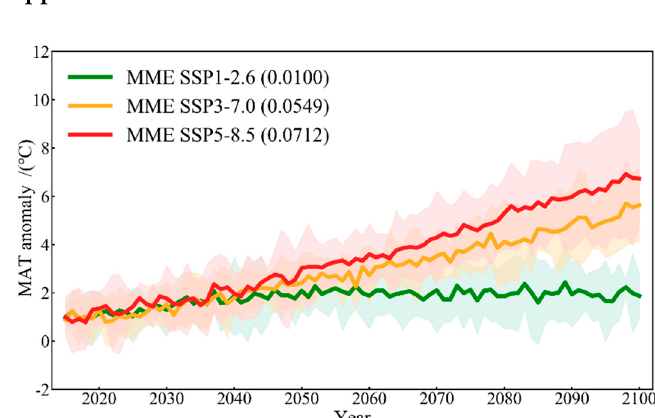
Figure A1. Regionally averaged annual MAT anomaly (units: °C) over the Qinghai-Tibet Plateau during 2015–2100 relative to 1951 − 2014 under SSP1-2.6, SSP3-7.0 and SSP5-8.5 scenarios as derived from five models and their ensemble mean with the same weights. The tendency rate of is shown in bracket of the legend.